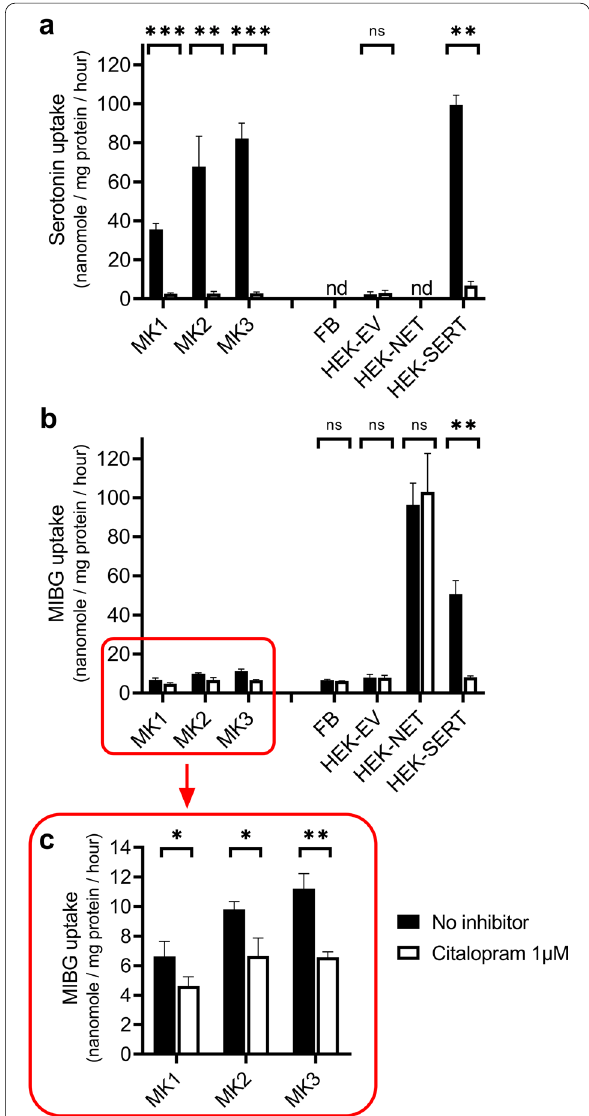
Fig.3 Uptake of serotonin and MIBG in cultured human megakaryocytes (MK1-3) after 10 days of differentiation and in SERT- and NET-transfected HEK293 cells. Samples were co-incubated with no inhibitor (black bars) or with the SSRI citalopram (1 μM; white bars). a Serotonin uptake in three megakaryocytic cell culture batches from three different healthy adult HSPC donors (MK1-3), fibroblasts (FB), and HEK293 cells transfected with an empty vector (HEK-EV), NET (HEK-NET), or SERT (HEK-SERT). b MIBG uptake in MK1-3, fibroblasts (FB), transfected HEK293 cells (HEK-EV, HEK-NET, HEK-SERT). c Close-up view of panel B showing MIBG uptake in MK1-3. The difference in MIBG uptake between samples with and without citalopram was significant in all three batches (MK1: p 0.043, MK2: p 0.014, MK3: p 0.002). Data represent mean SD. = = = + Please note the different scales of the Y-axis. Asterisks were used to indicate significance levels: p < 0.05 (*), p 0.01 (**), and p 0.001 ≤ ≤ (***). Serotonin/MIBG uptake is expressed as nanomole of substrate uptake per milligram protein per